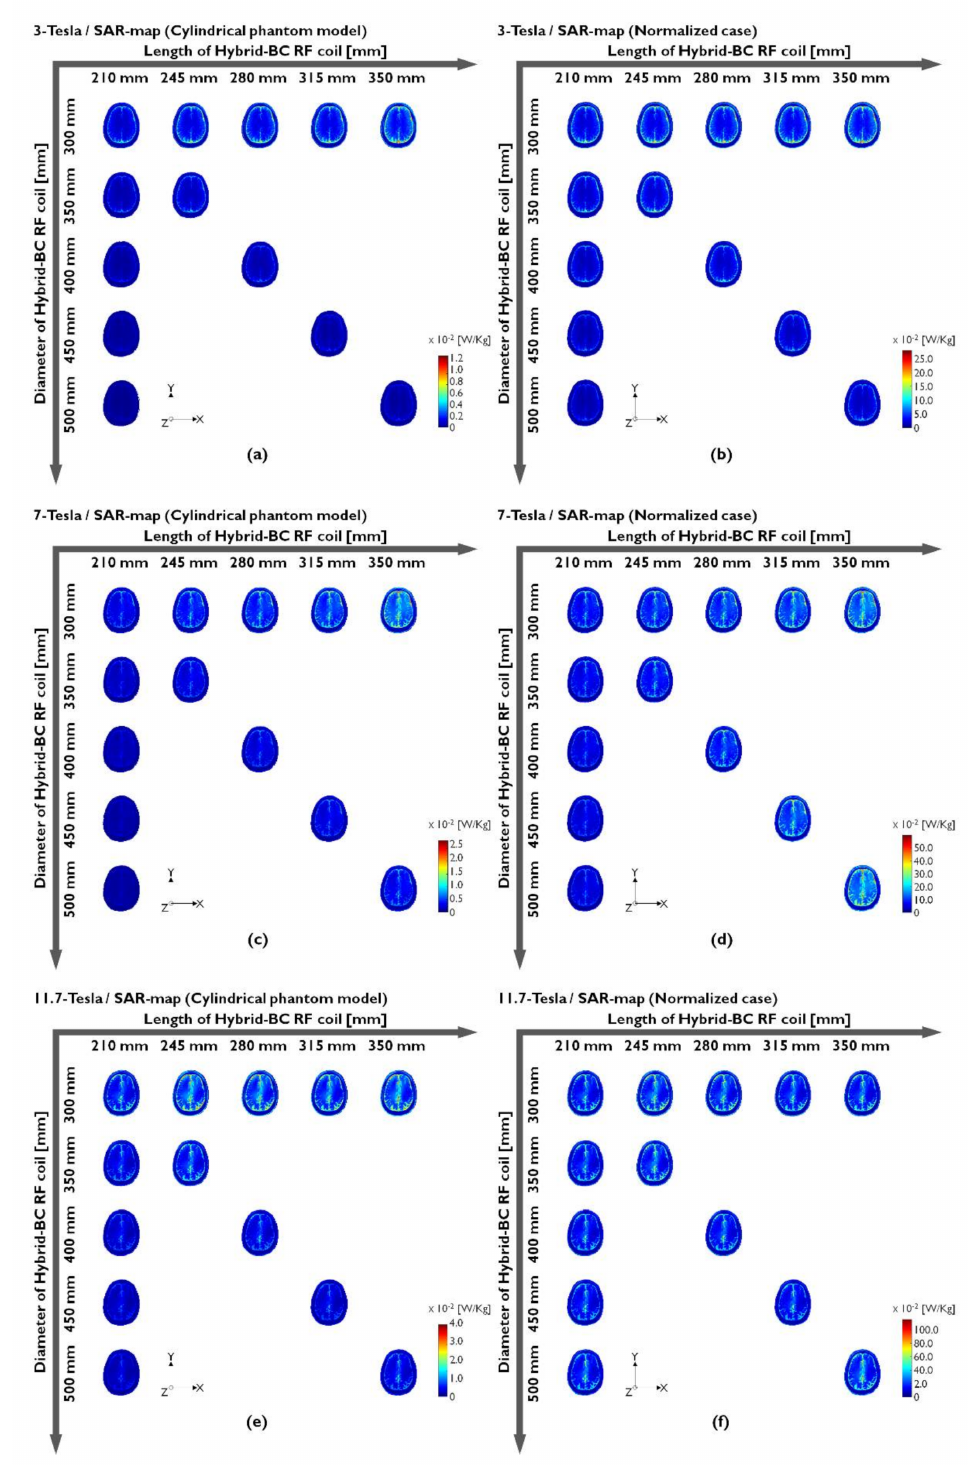
Figure 6. SAR maps generated under unnormalized ( a , c , e ) or normalized ( b , d , f ) conditions when using a human body